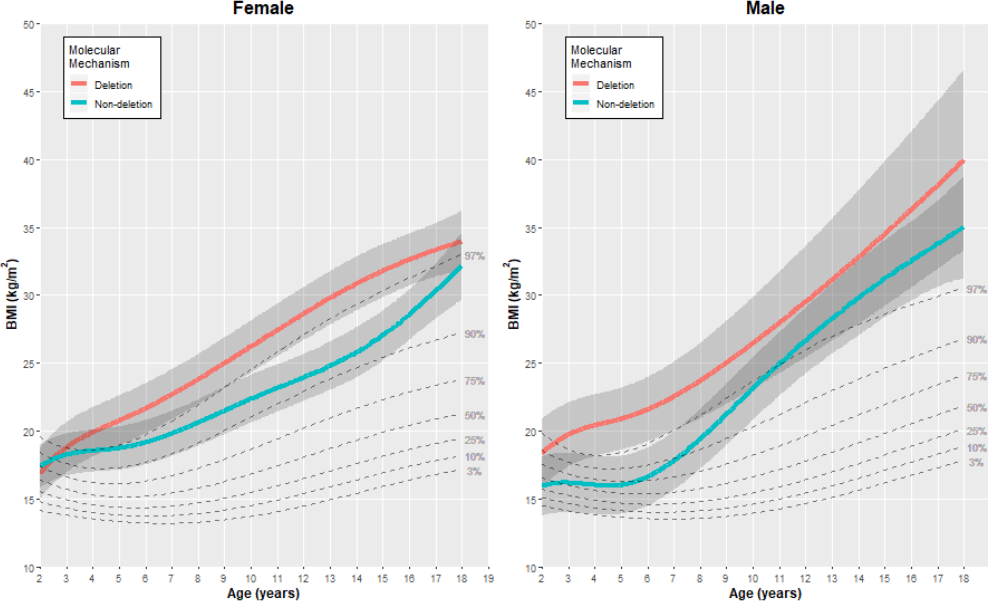
Figure 4. Estimated growth curves for the BMI of individuals with the deletion or non-deletion mechanism causing PWS in our study cohort (colored lines), alongside the normative percentile ranges of BMI growth (dashed gray lines).